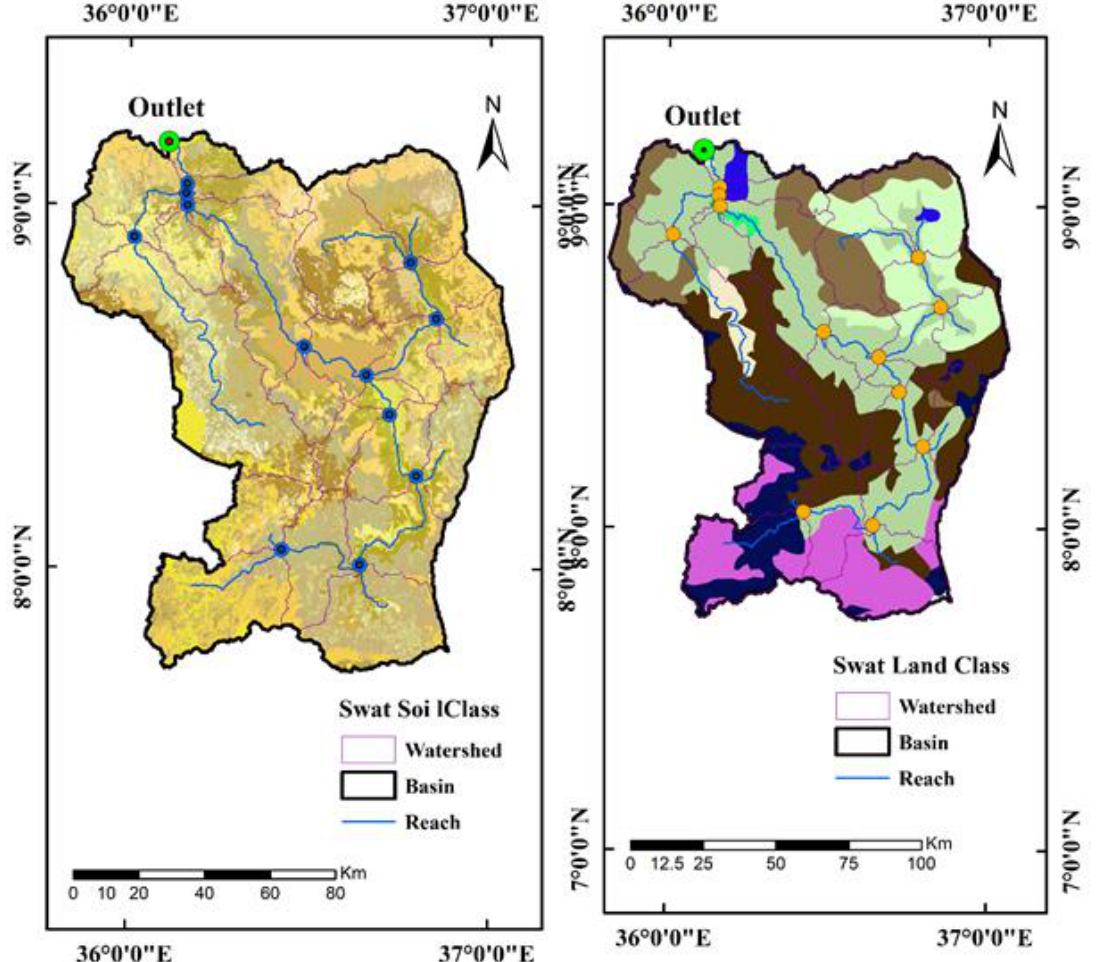
Figure 5. Soil and land use data used in the Soil and Water Assessment Tool (SWAT) model for the Dhidhessa sub-basin.